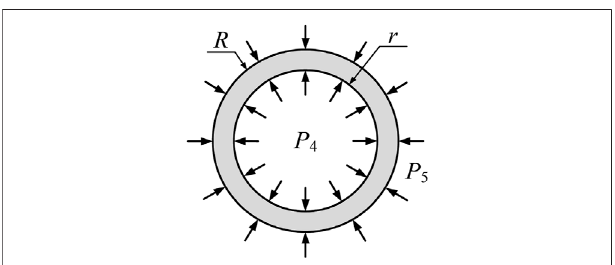
FIGURE 4 | Lining force analysis